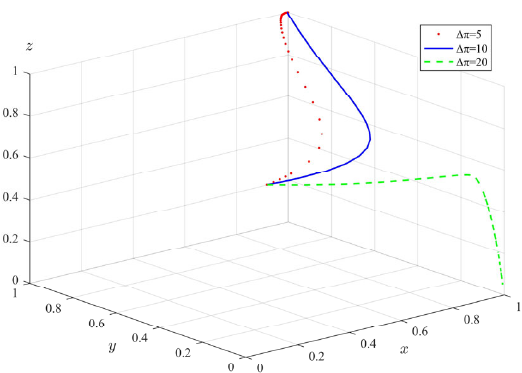
Figure 9. The impact of additional benefits ( ∆ π ) on the evolution of tripartite behavior.